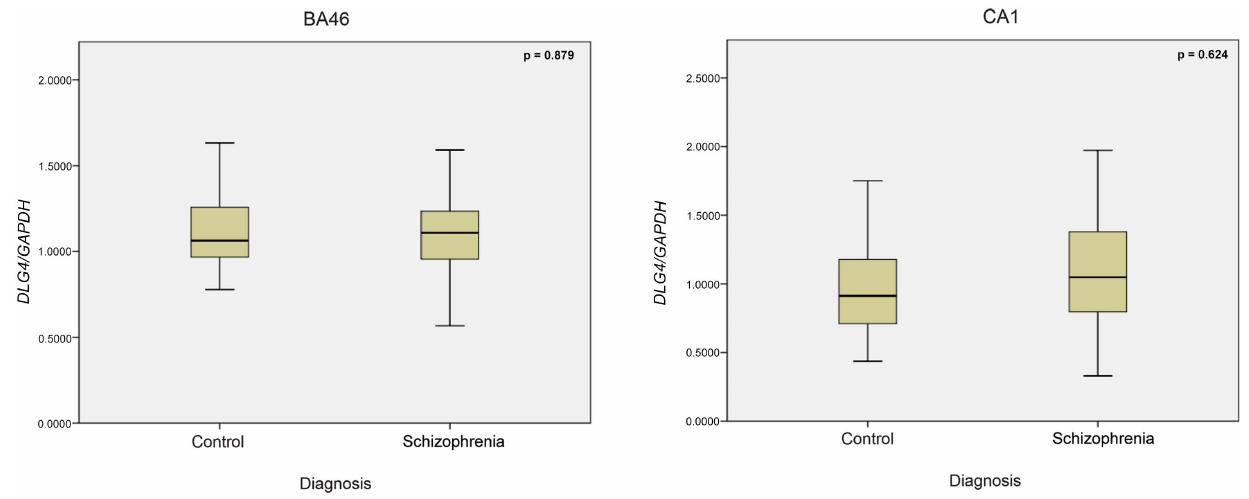
Figure 2. DLG4 gene expression analysis in BA46 and CA1 region of postmortem brain samples from schizophrenia patients and controls.